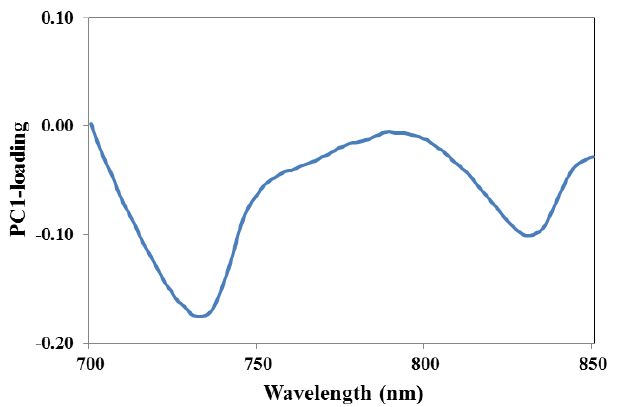
Fig. 12. Loading plot of principle component